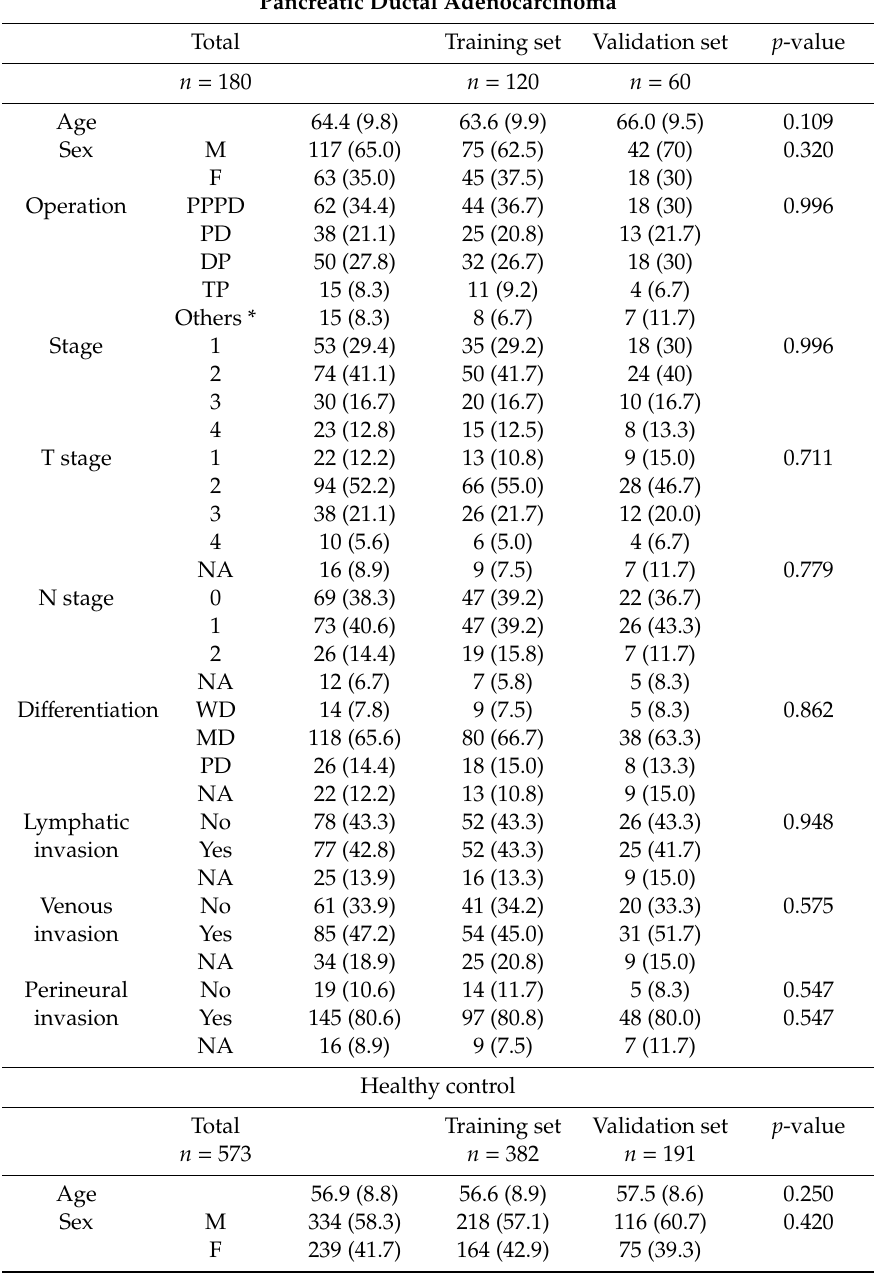
Table 1. Demographics and clinicopathological characteristics of pancreatic ductal adenocarcinoma patients and healthy controls used in the training and validation